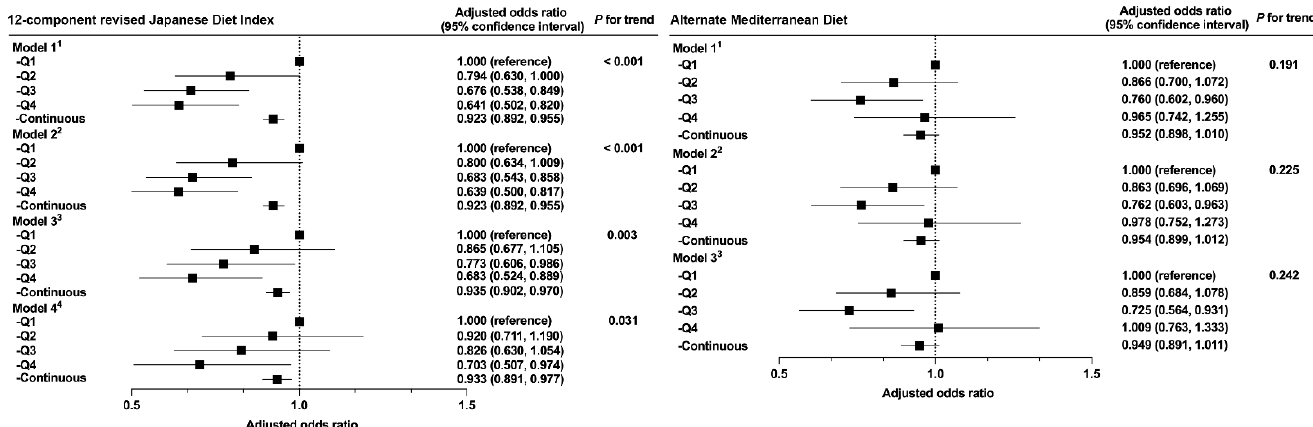
Figure 2. Relationship between the two dietary patterns and muscle weakness. 1 Model 1 was adjusted for age (50–54, 55–59, 60–64, 65–69, or ≥70 y) and sex. 2 Model 2 was adjusted for Model 1 plus BMI (<18.5, 18.5–25, ≥25 kg/m2, or missing). 3 Model 3 was adjusted for Model 2 plus IADL score (TMIG-IC score), time spent walking (≥1, 0.5–1, <0.5 h/d, or missing), alcohol consumption (every day, sometimes, never, or missing), smoking status (current, former, never, or missing), and history of diseases (cerebrovascular disease, coronary heart disease, diabetes, cancer (yes, no, or missing for each term)). 4 Model 4 was adjusted for Model 3 plus energy intake (kcal/d; sex-specific quintile categories). Continuous variables were entered into each model as continuous values for each dietary score.